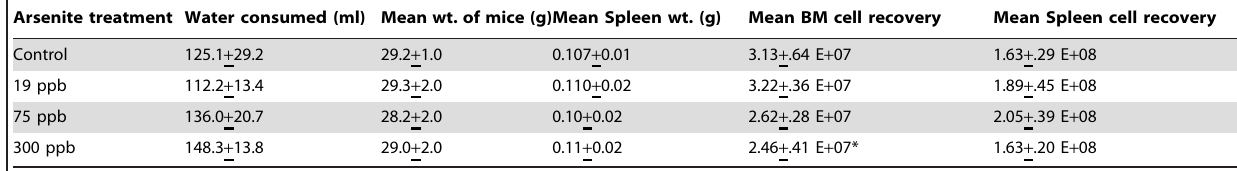
Table 1. 30 Day Arsenic Drinking Water Exposure and Effects on Mouse Body Weight, Spleen Weight, Bone marrow Cell and Spleen Cell recovery